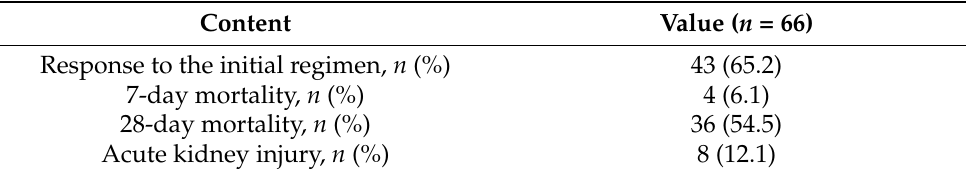
Table 6. Treatment outcomes, acute kidney